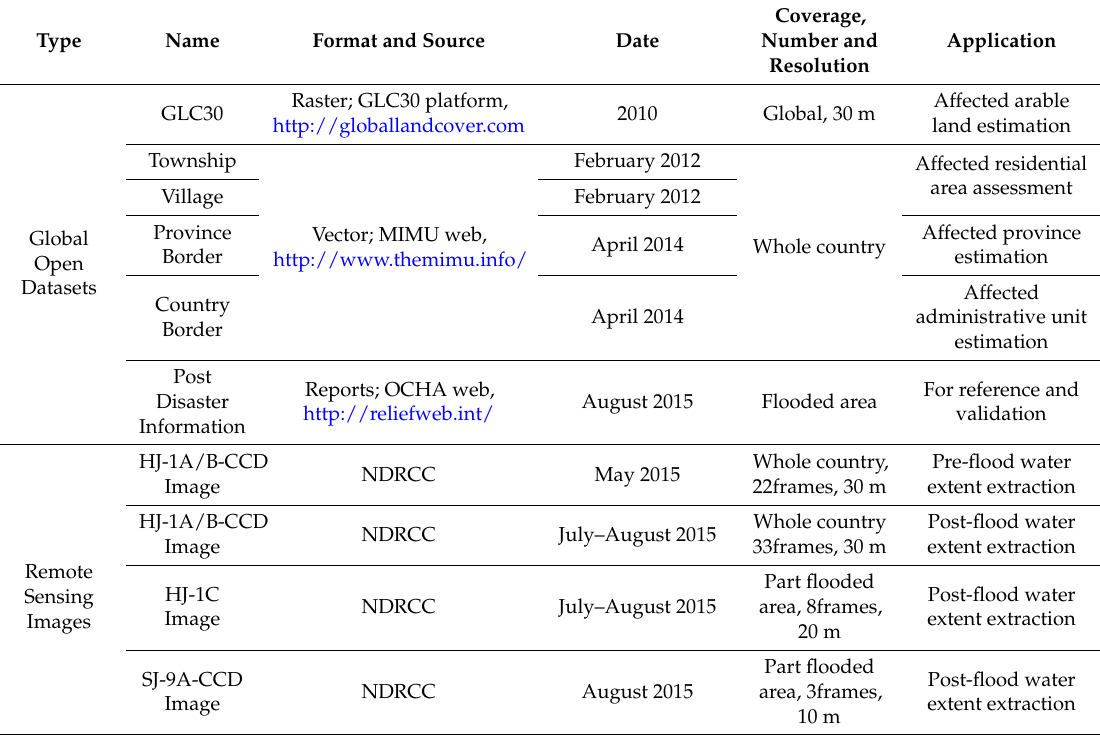
Table 1. Data Used for Flood Impact